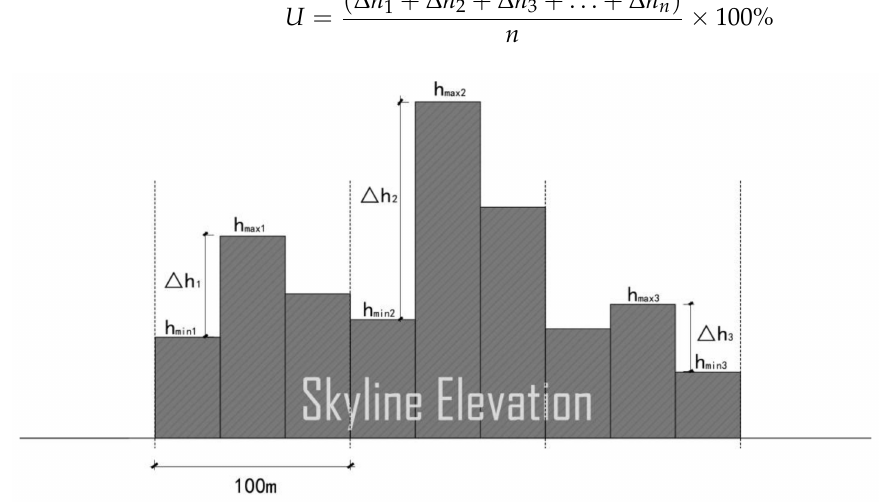
Figure 2. Building undulation.